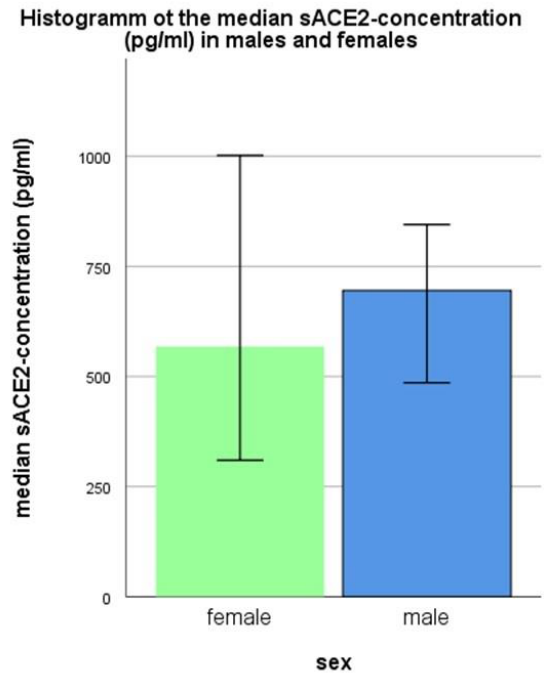
Figure 1. Association of sex and sACE2-concentration within all individuals included in the study (median and 95% confidence interval is shown) .